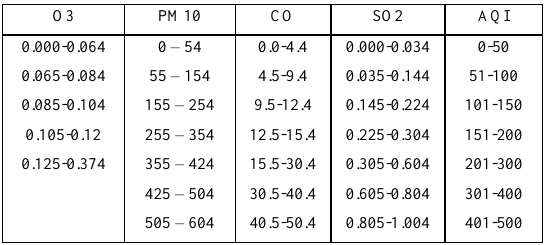
Table 1- Breakpoints of Sensor Observation and for Calculating AQI